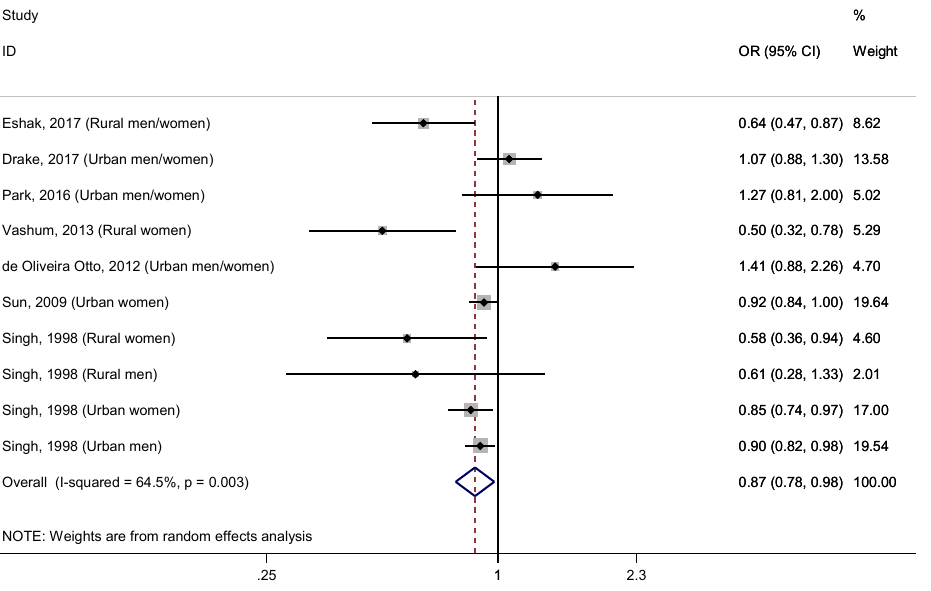
Figure 2. Forest plot of pooled effect size of the highest versus lowest dietary zinc intake for T2DM. Squares represent odds ratios (OR) for each study, and the size of the square is the study-specific statistical weight. Horizontal lines indicate the 95% CI of each study. Diamond represents the combined OR estimate with corresponding 95% CI.